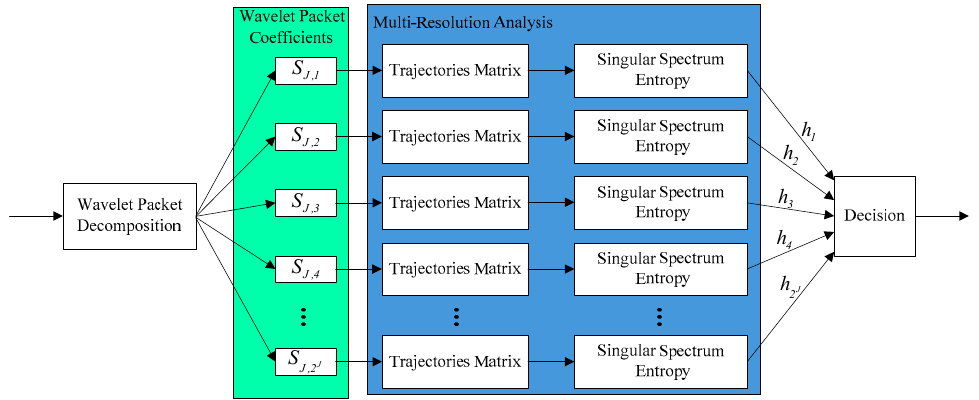
Figure 5. Signal processing flow in the multi-resolution analysis module, singular spectrum module entropy and decision module.